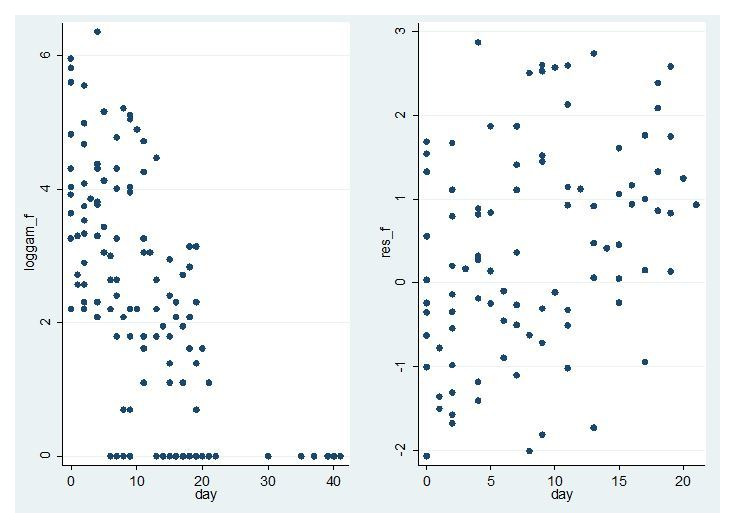
Model fit for CHMI-trans data female gametocytes.Log female gametocyte densities at different days of follow-up (left) and residuals of non-zero female log gametocyte densities as a function of time of follow-up (right).